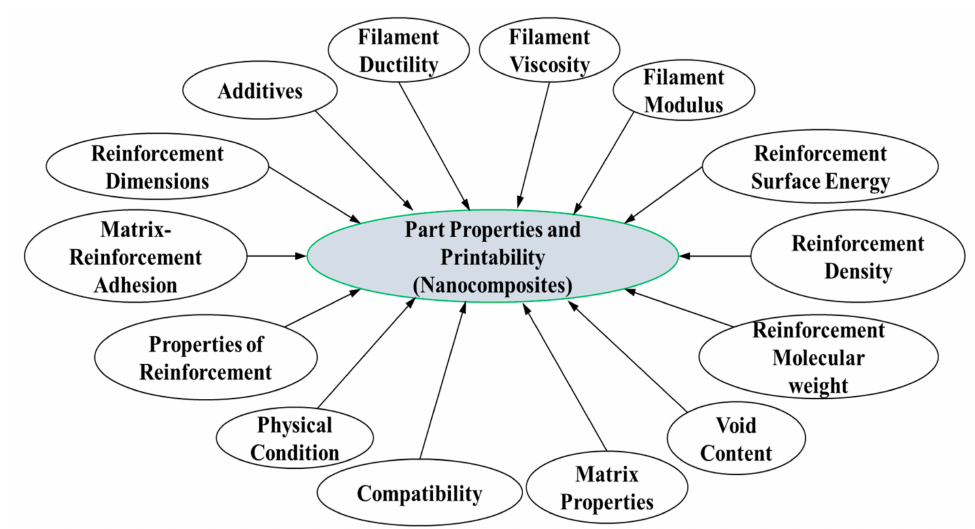
Figure 8. The factors for part properties and printability of nanocomposite filaments.